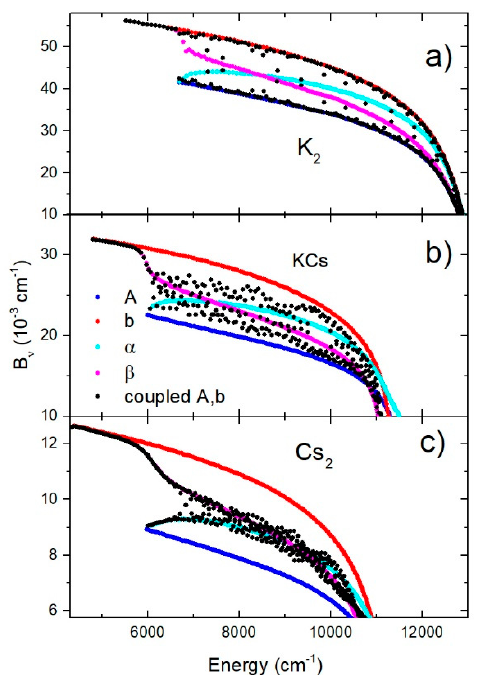
Figure 5. Constants of A, b, α , and β , as well as the coupled A and b electronic states, in the case of K 2 , KCs, and Cs 2 molecules are shown in ( a – c ), respectively.